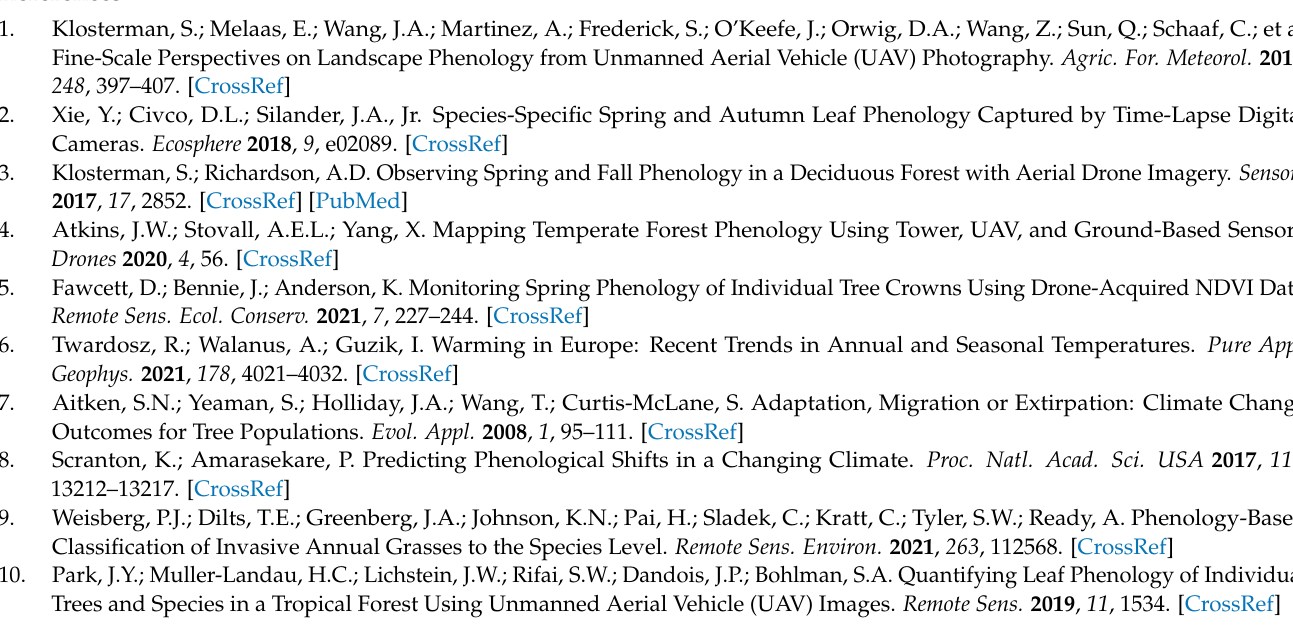
Figure A4. Correlation analysis between Copernicus biophysical parameters and the mean phenological phase of each study site.